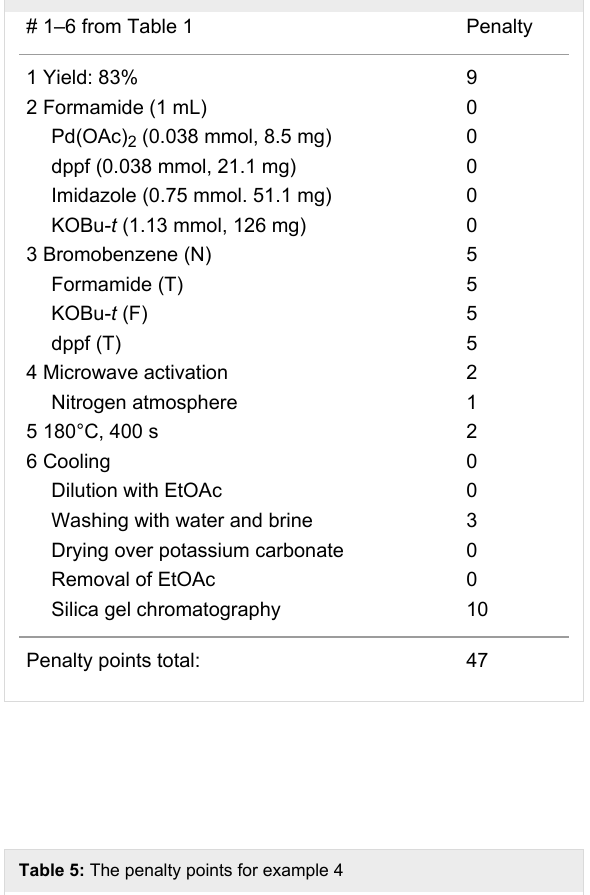
Table 5: The penalty points for example